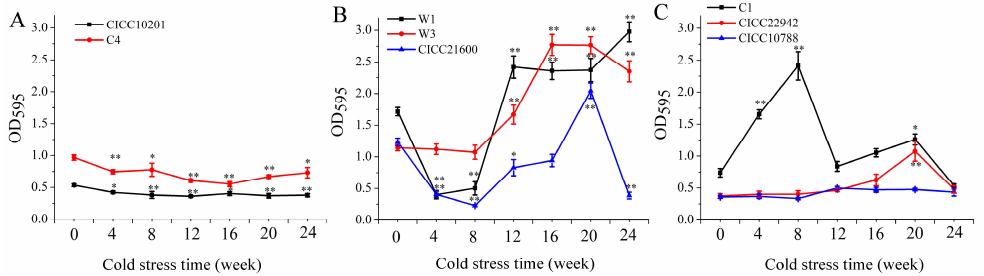
Figure 1. Biofilm formation of S. aureus cells after cold stress at − 20 ◦ C. Note: ( A ): Biofilm formation of S. aureus CICC 10201 and C4. ( B ): Biofilm formation of S. aureus W1, W3 and CICC 21600. ( C ): Biofilm formation of S. aureus C1, CICC 22942 and CICC 10788. Strains without cold stress were used as control samples, and strains after cold stress at − 20 ◦ C for 4 weeks, 8 weeks, 12 weeks, 16 weeks, 20 weeks, or 24 weeks were used as the treatment groups. **: Compared with the control groups, the tested sample were significantly different ( p < 0.01), *: Compared with the control group, the treated sample were different ( p < 0.05). The values were means ± standard deviations (SD, n =